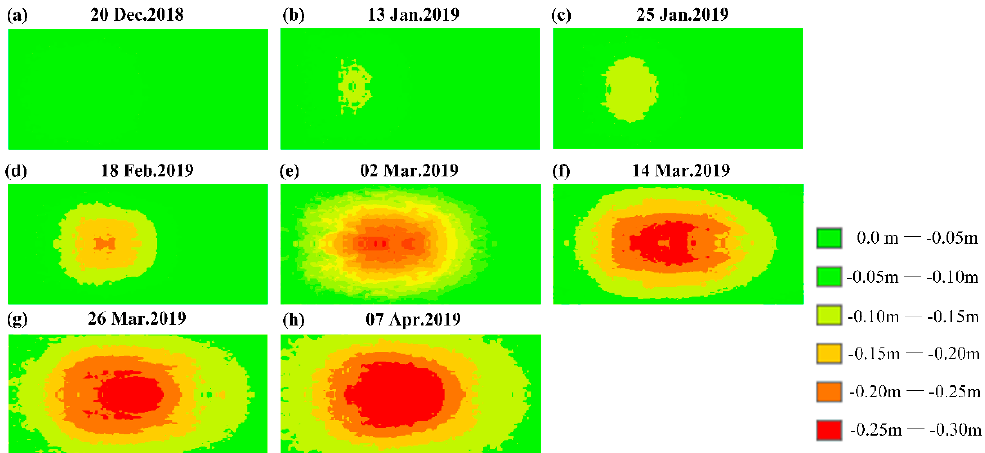
Figure 8. SGI-SF-derived time series of vertical subsidence with reference to 26 November 2018. ( a )–( h ) are the vertical subsidence results between 26 November 2018, 20 December 2018, 13 Janu- April 2019 with 26 November 2018 respectively.